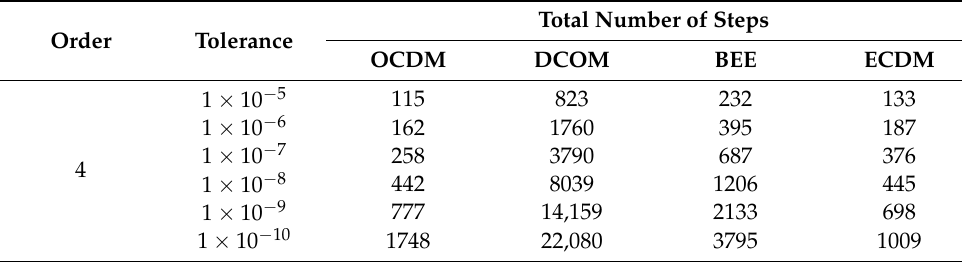
Figure 7. Graphs of step size behavior for different controllers under investigation for Van der Pol oscillator. Table 5. Dependence between the total number of steps and tolerance for Van der Pol